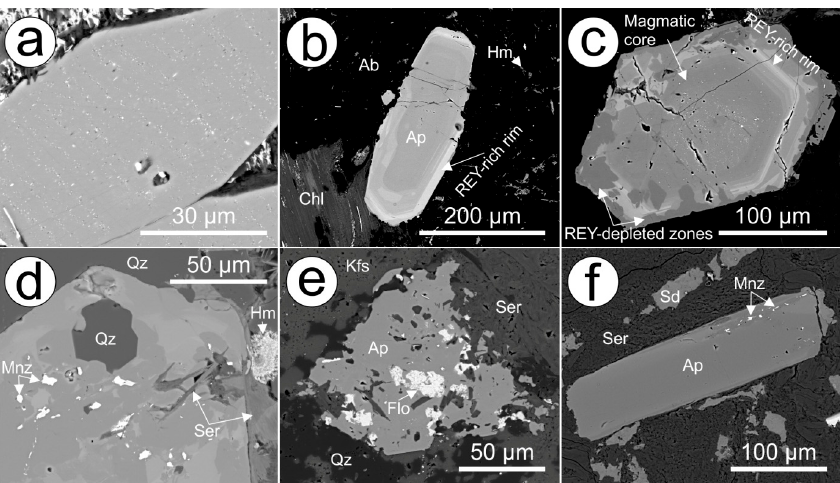
Figure 2. Back-scatter electron (BSE) images showing the textural and morphological character of apatite hosted in igneous rocks. ( a ) Magmatic apatite with numerous minute inclusions of a Fe-sulphide mineral; ( b ) Apatite grain displaying a rare earth element and Y (REY)-enriched rim and a magmatic core hosted within albite adjacent to biotite now replaced by chlorite; ( c ) Apatite grain showing a inclusion-rich magmatic core, REY-rich rim and zones of REY-depletion on the margin of the grain affecting both the magmatic core and REY-rich rim; ( d ) Magmatic apatite within pervasively altered Roxby Downs granite (RDG) displaying broad zones of REY-depletion that contain numerous inclusions of sericite and monazite; ( e ) Apatite associated with the hematite-sericite alteration of the RDG with numerous inclusions of sericite and florencite; ( f ) Unzoned apatite with a REY-depleted zone containing small grains of monazite (hematite-sericite altered dolerite dyke (DD)). Abbreviations: Ab-albite, Ap-apatite, Chl-chlorite, Flo-florencite, Hm-hematite, Kfs-K-feldspar, Mnz-monazite, Qz-quartz, Sd-siderite, Ser-sericite.